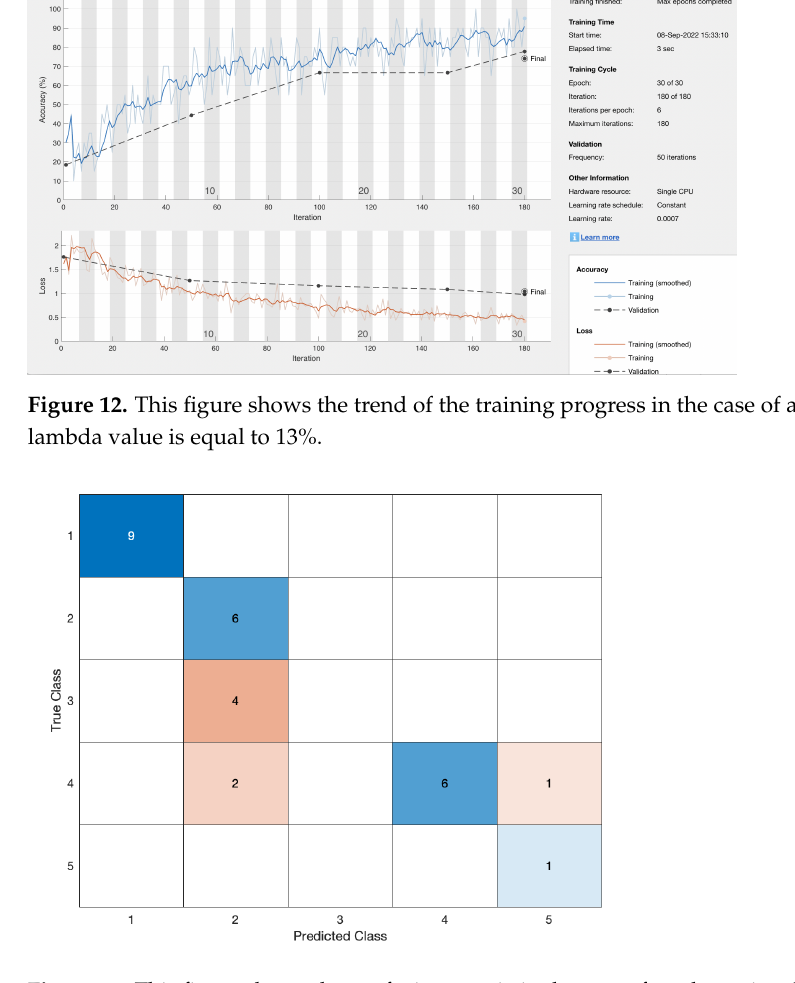
Figure 13. This figure shows the confusion matrix in the case of a subarea in which the lambda value is equal to